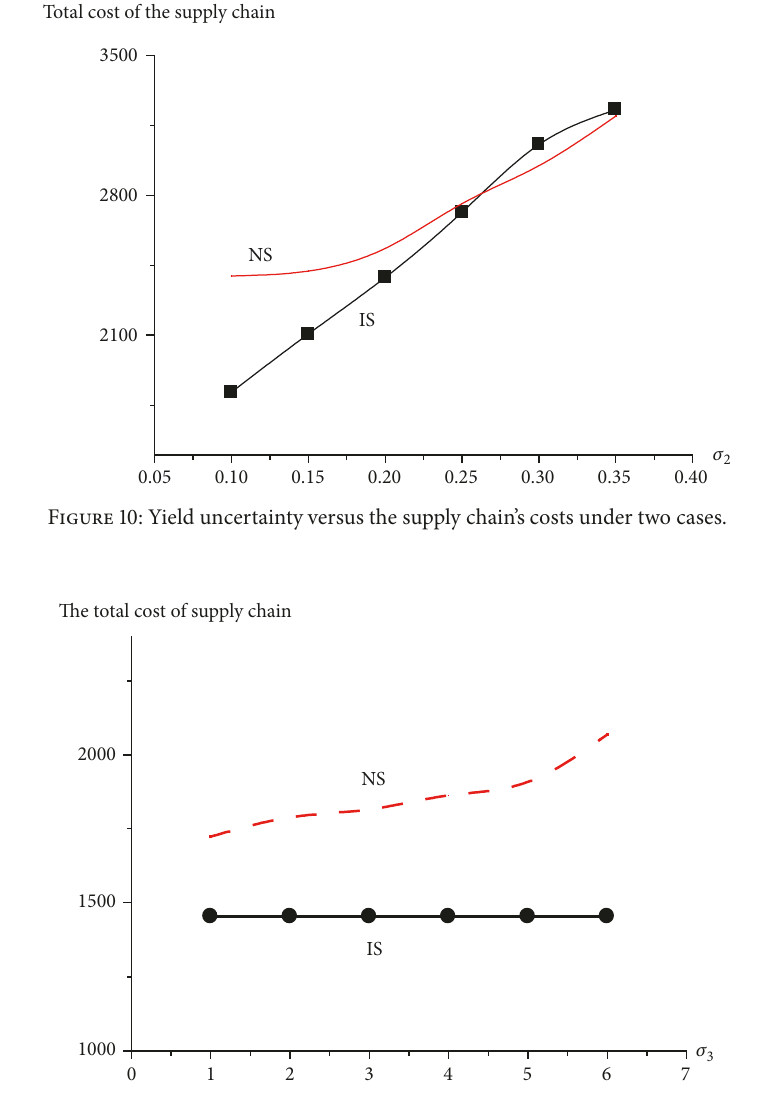
Figure 11: Order process uncertainty versus the supply chain’s costs under two